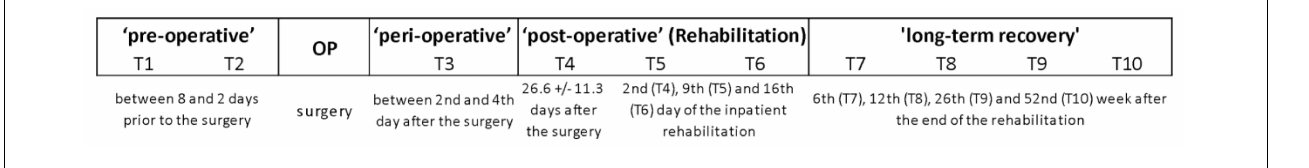
FIGURE 1 | Shematic representation of the division of operation-rehabilitation process into phases and measurement days for the purposes of our